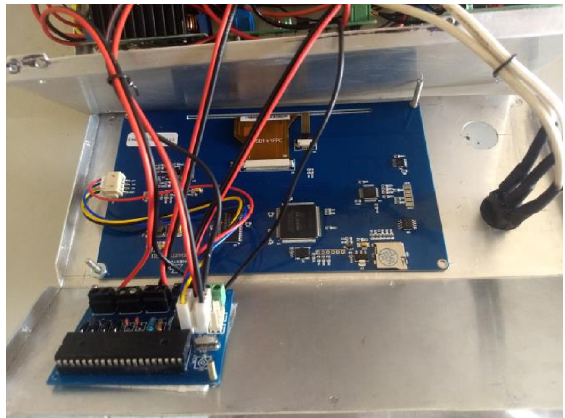
Figure 13. HMI connected to an electronic circuit board.